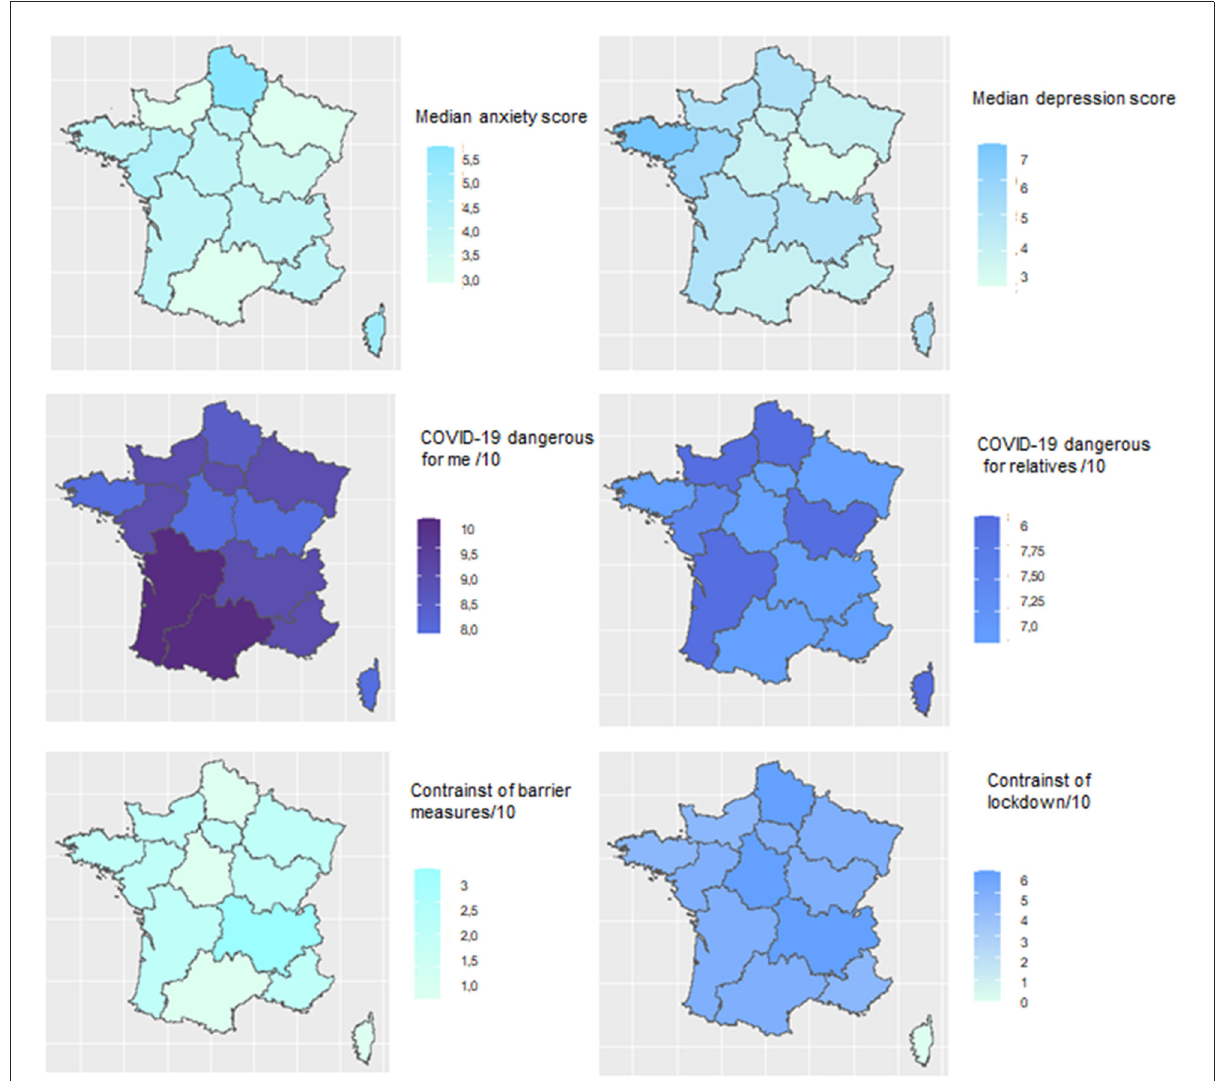
FIGURE1 Health impact of the COVID-19 epidemic and associated lockdown measures on cystic fibrosis patients during the first wave of COVID-19 according to different geographic regions of France. Assessment of anxiety and depression: participants were asked to complete the 7-Item Generalized Anxiety Disorder Scale (GAD-7) (13) and the validated French version of the 9-item Patient Health Questionnaire Depression Scale (PHQ-9) (14, 15). The total GAD-7 score ranges from 0 to 21, with a cut off of 10 indicating the presence of significant anxiety symptoms. The PHQ-9 score is composed of nine depression symptom items listed in the Diagnostic and Statistical Manual of Mental Disorders-4th edition (DSMIV) for depression and ranges from 0 to 27 ( 14). The median score is indicated for each metropolitan French geographic area. “COVID-19 dangerous for me,” “COVID-19 dangerous for relatives,” constraints from barrier measures, and constraints from lockdown were assessed using a scale of 1 to 10, with 1 being “very low” and 10 being “very high.” Results are represented for each of the French geographic areas, with colors that correspond to the values in an intuitive manner (higher values are darker blue, while lower values are lighter blue).